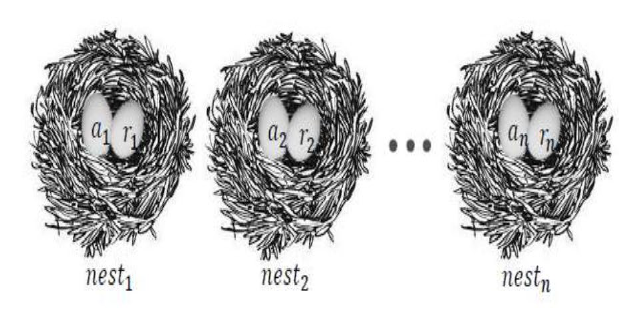
Figure 3. Readers creation and Nests